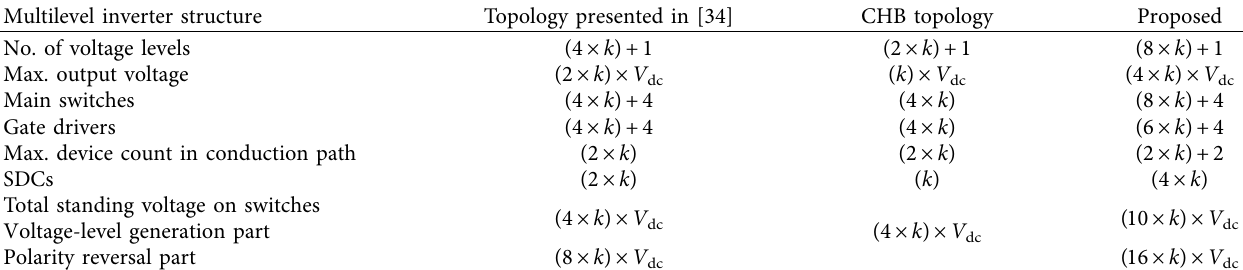
Table 1: Comparison between proposed and conventional single-phase topologies for “ k ” cells. Multilevel inverter structure